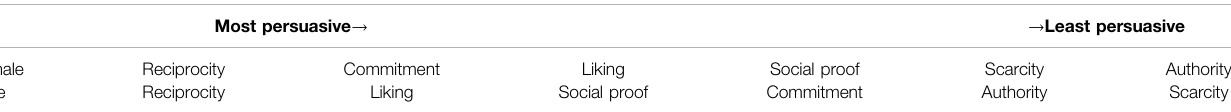
TABLE 4 | Persuasion pro fi les based on